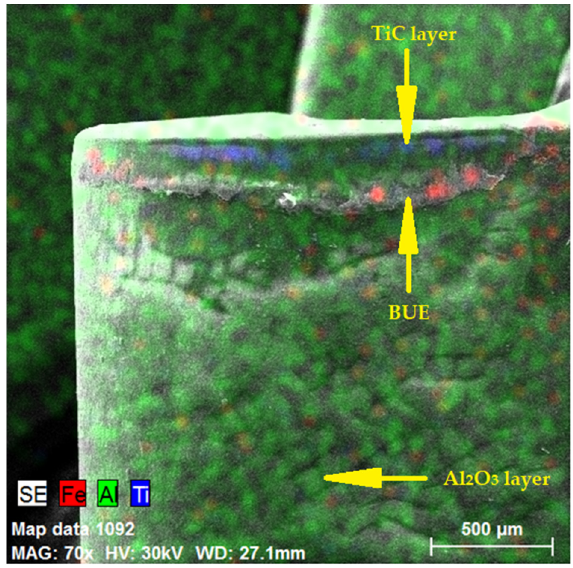
Figure 10. EDX analysis of wear range of CNMG 120408E-M GRADE T9315.